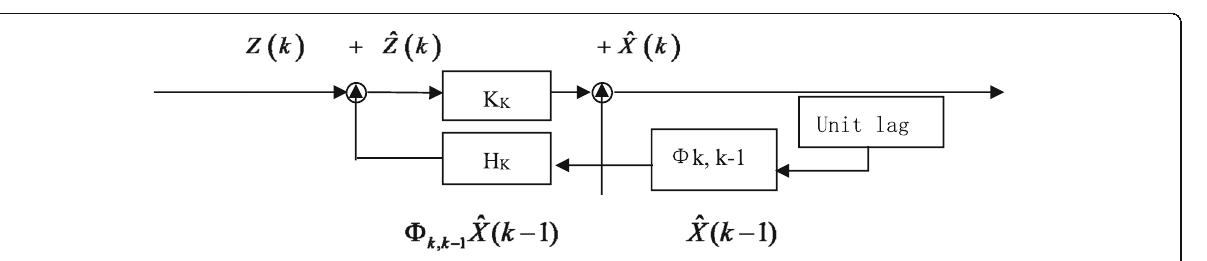
Fig. 2 Structure diagram of Kalman filtering of random linear discrete